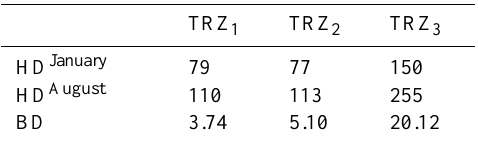
Table 8. HTR daily in January and August and BTR (in Euro) daily in the TRZ i ( i = 1 , 2 ,